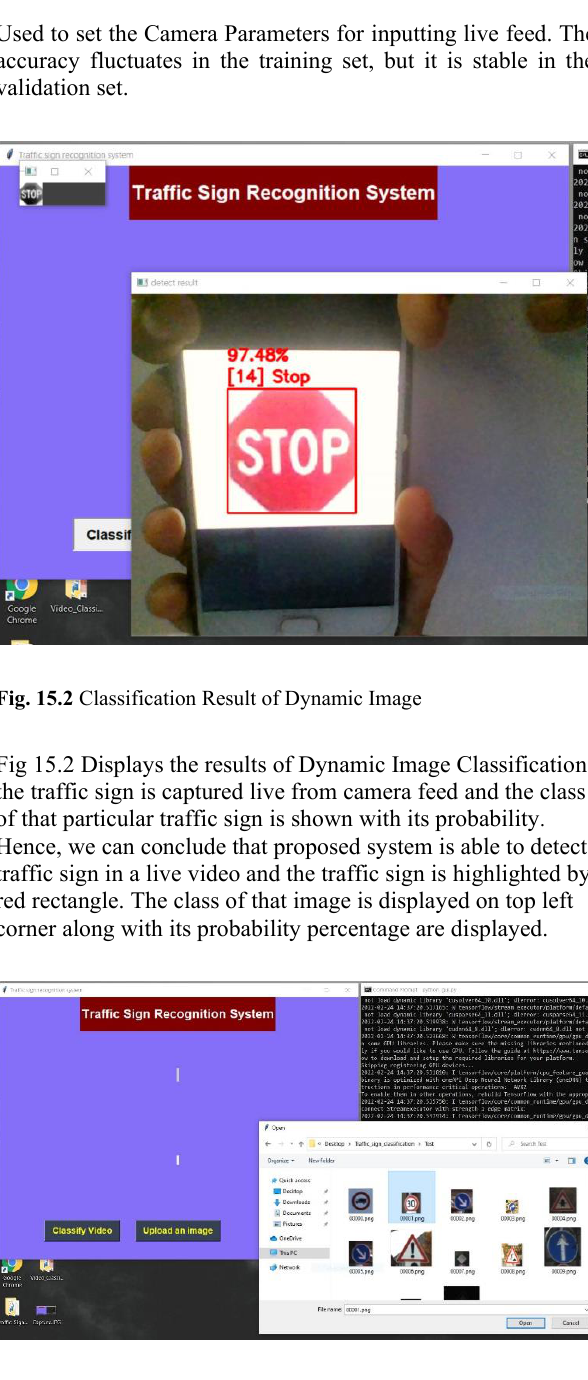
Fig. 15.3 Input static image from proposed